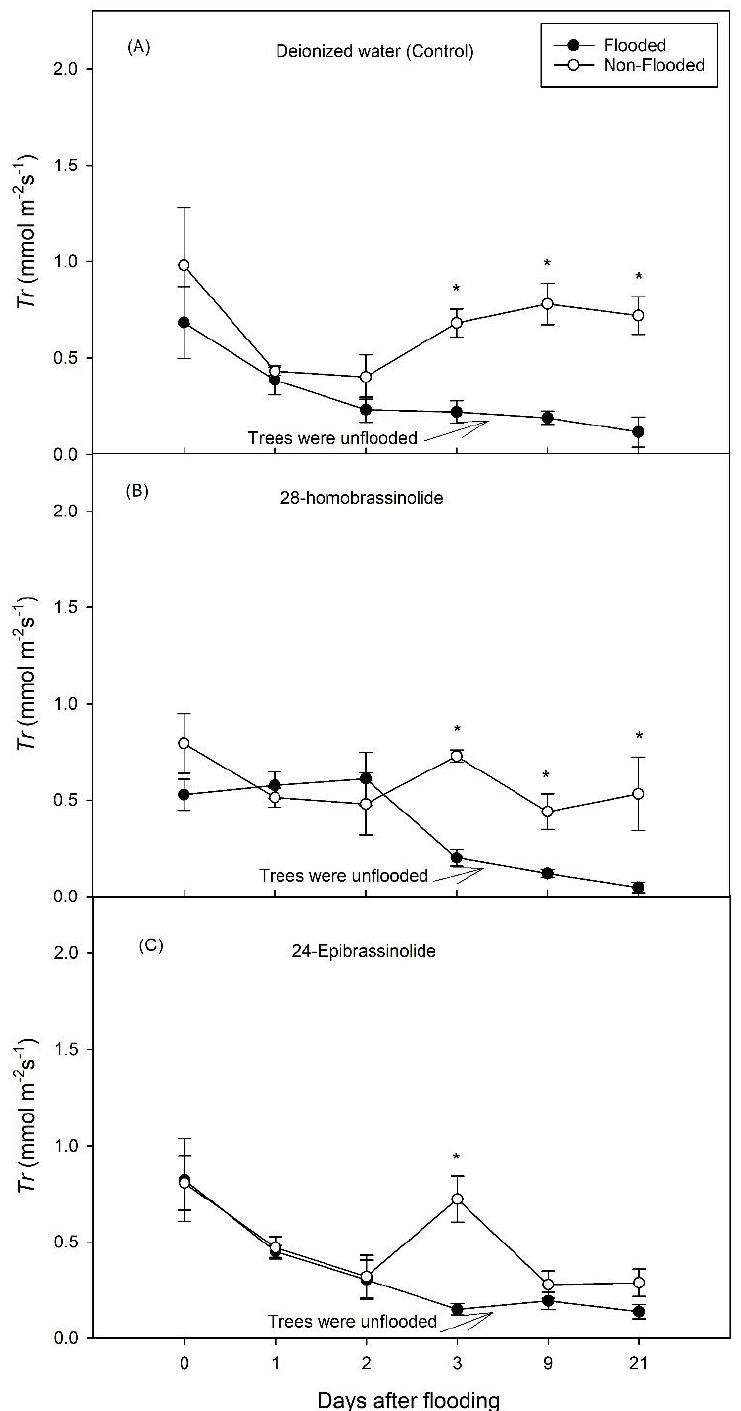
Figure 8. Effect of flooding on transpiration ( Tr ) of ‘Reed’ avocado trees treated with ( A ) deionized water as a control, ( B ) 28-homobrassinolide, or ( C ) 24-epibrassinolide, (Experiment 2). Symbols and bars indicate means ± std. err. Significant differences ( p ≤ 0.05) between flooding treatments are indicated with an asterisk and were determined by repeated-measures ANOVA. ‘Trees were unflooded’ indicates the day on which trees were removed from the flooding treatment to start the recovery period.